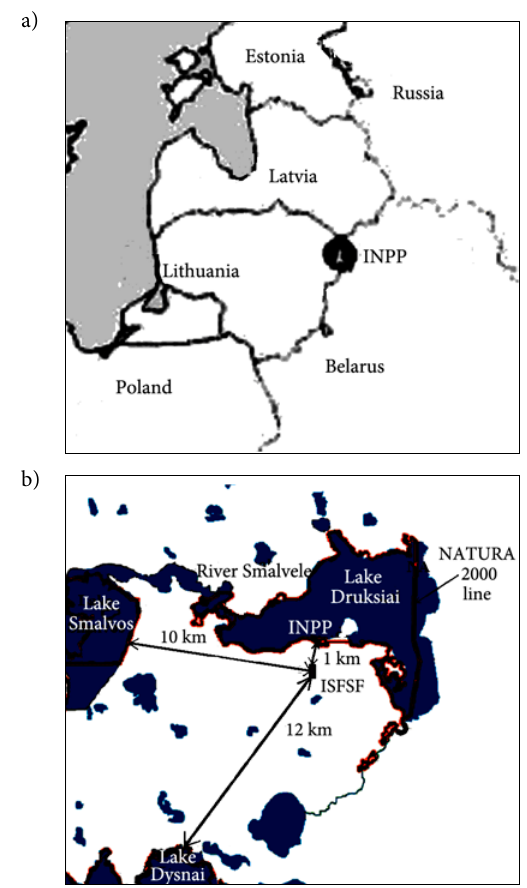
Fig. 1. (a) INPP geographical location, (b) The regional level map with marked INPP, ISFSF locations and